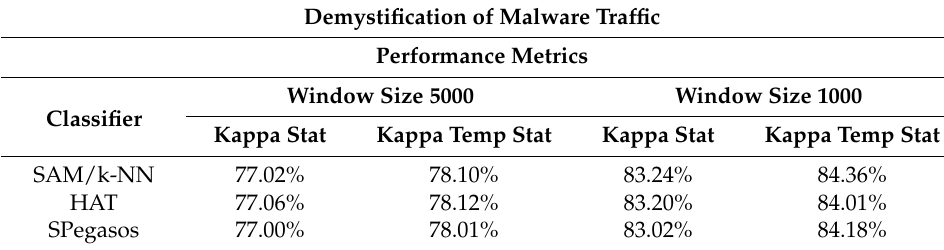
Table 8. Comparison between algorithms.